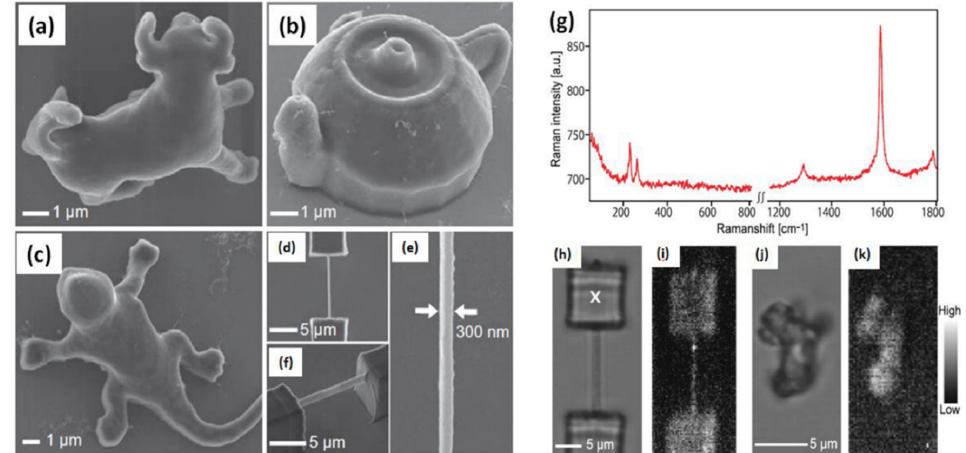
Figure 10. 3D micro/nano structural SWCNT/polymer composites are fabricated by using the TPP